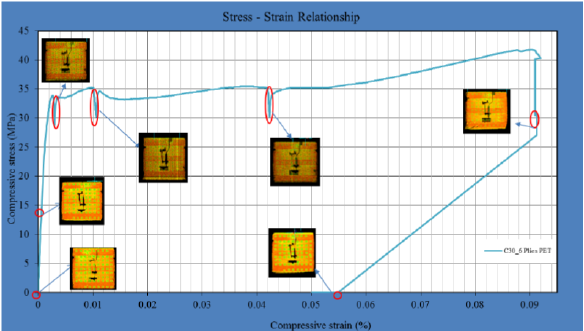
Figure 4. The relationship between compressive stress and strain for C30_6P sample with 7 scanning phase